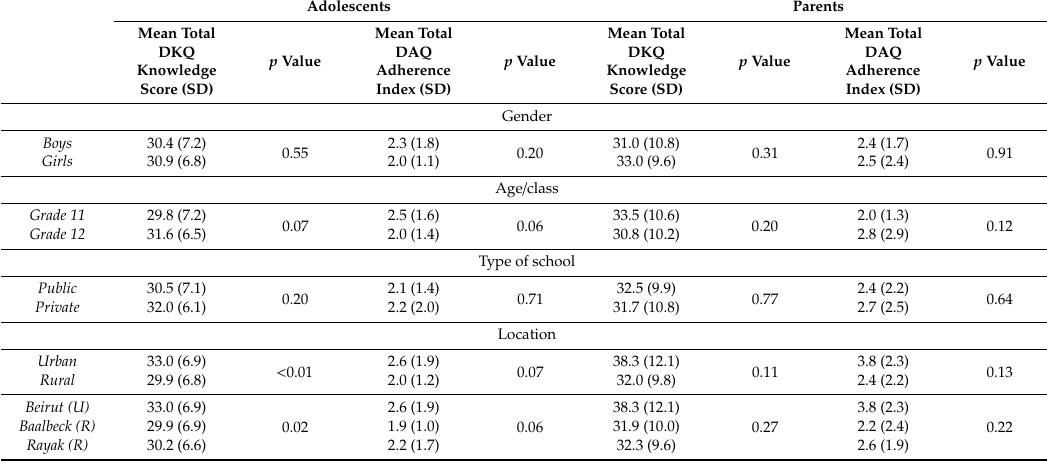
Table 5. Means and di ff erences in total knowledge and adherence scores among adolescents and